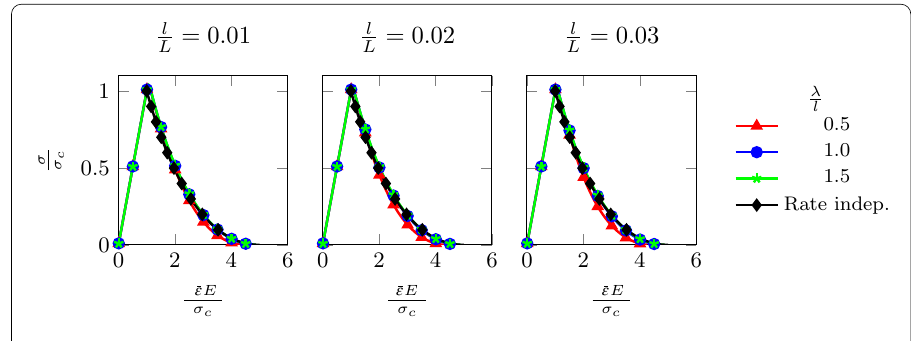
Fig. 11 The overall stress-strain response of the integral averaging model for different interphase band thicknesses and nonlocal length scales